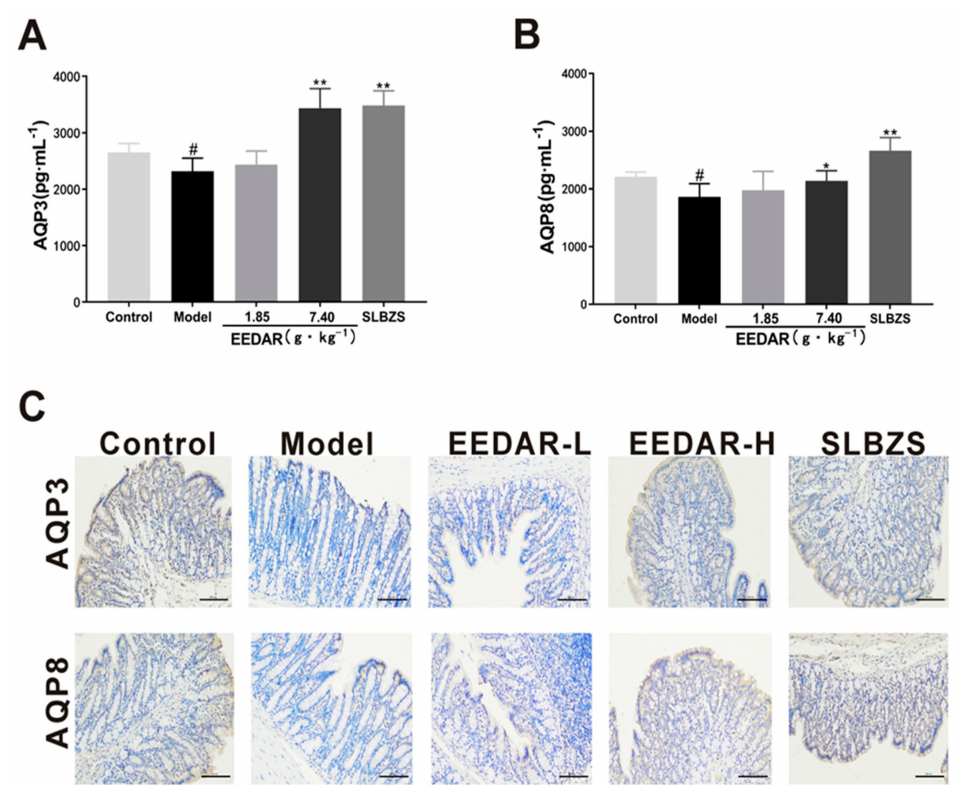
Figure 4. E ff ect of EEDAR on AQP3 and AQP8 in spleen-deficiency diarrhea rats ( n = 10). The levels of AQP3 ( A ) and AQP8 ( B ) in the colon were determined by ELISA. Representative images of AQP3 and AQP8 ( C ) IHC sections (200 × magnification) from colons indicated di ff erent pathological changes in spleen deficiency diarrhea rats treated with EEDAR-L (1.85 g · kg − 1 ), EEDAR-H (7.40 g · kg − 1 ), and SLBZS. Values represent means ± SEM. # p < 0.05, vs. Control; * p < 0.05, ** p < 0.01 vs. Model. (Scale bar 1:100).